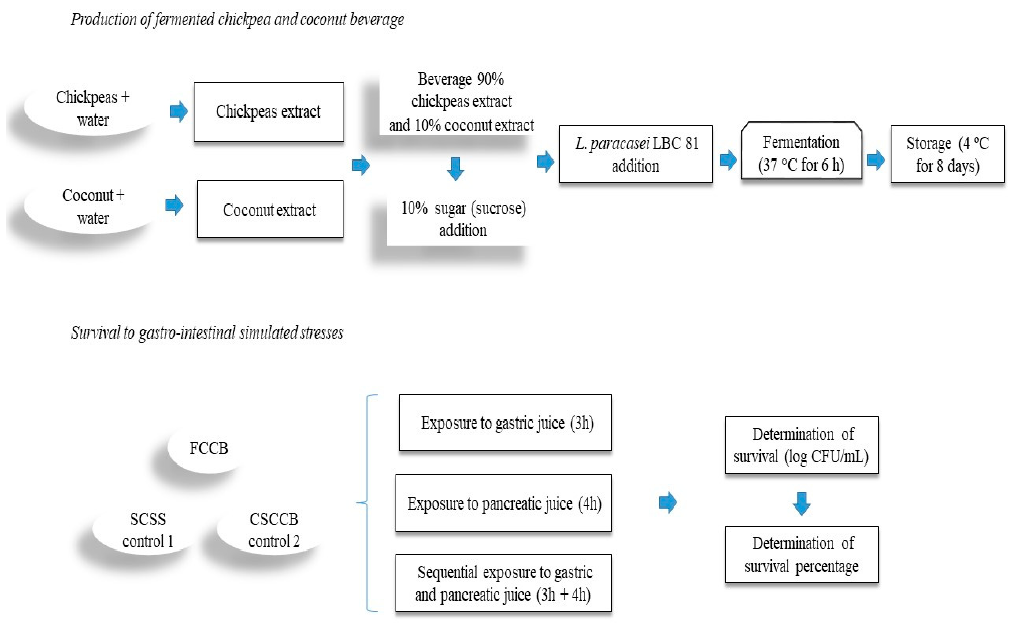
Figure 1. Chickpea and coconut production steps and survival experiments to gastrointestinal simulated stresses.